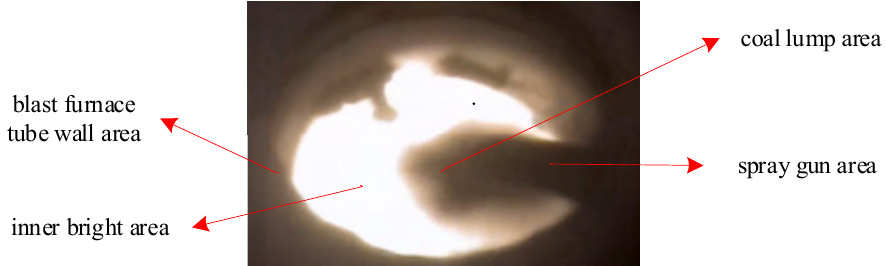
Figure 1. Structure diagram of blast furnace tuyere.